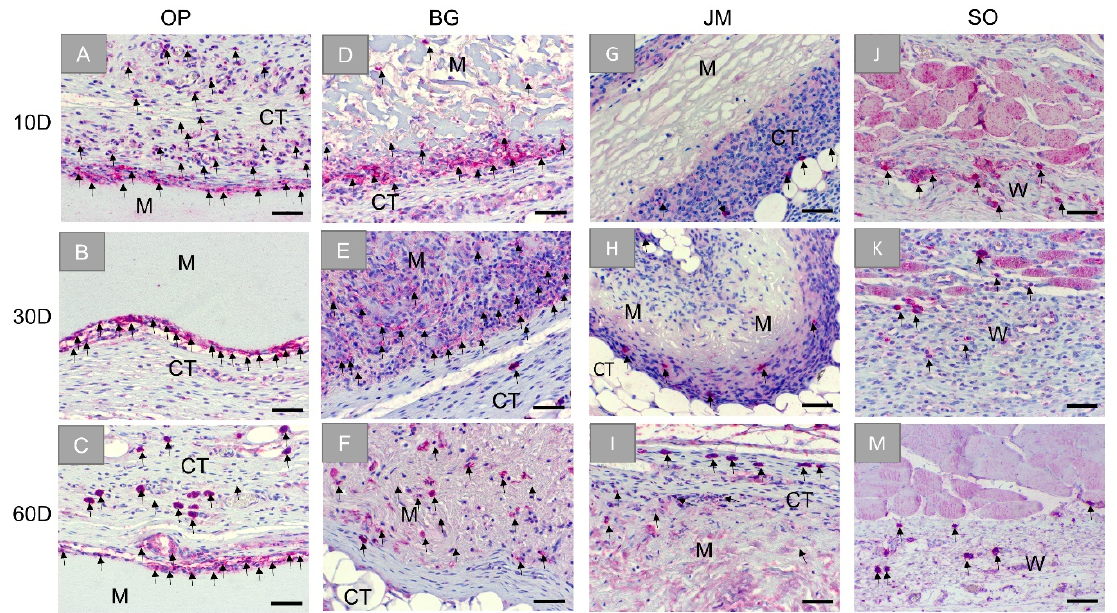
Figure 7. Exemplary images of the immunohistochemical detection of pro-inflammatory M1 macrophage within the bed implants of the different barrier membranes and the sham operation group at three time points: 10 days, 30 days, and 60 days. First column: Ossix ® Plus (OP) ( A – C ), second column: Bio-Gide ® (BG) ( D – F ), third column: Jason ® membrane (JM) ( G – I ), and forth column: sham operation (SO) ( J – M ). CT: connective tissue, M: membranes, W: wound area, black arrows: CD11c-positive cells (CD11c-immunostainings, 20 × objective magnifications and scalebars = 50 µ m).